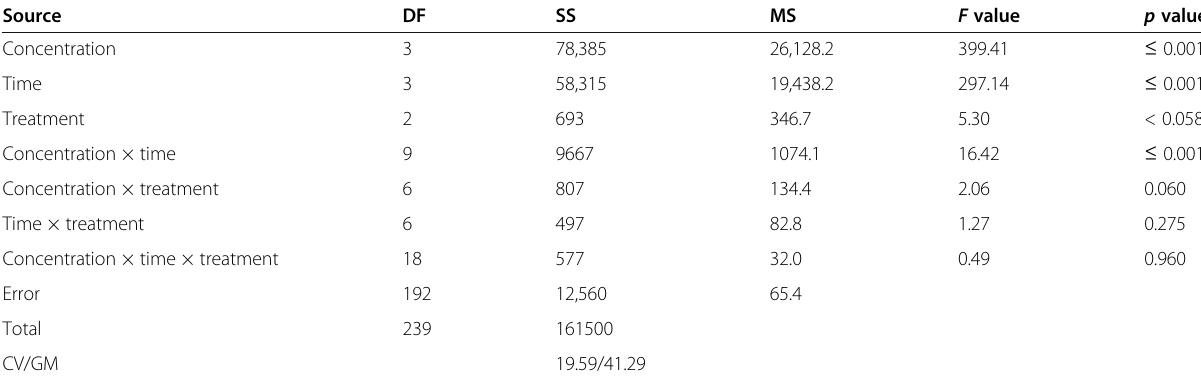
Table 1 Factorial analysis of variance of the mortality rate of Bemisia tabaci bioassay with the conidia of the three Lecanicillium lecanii